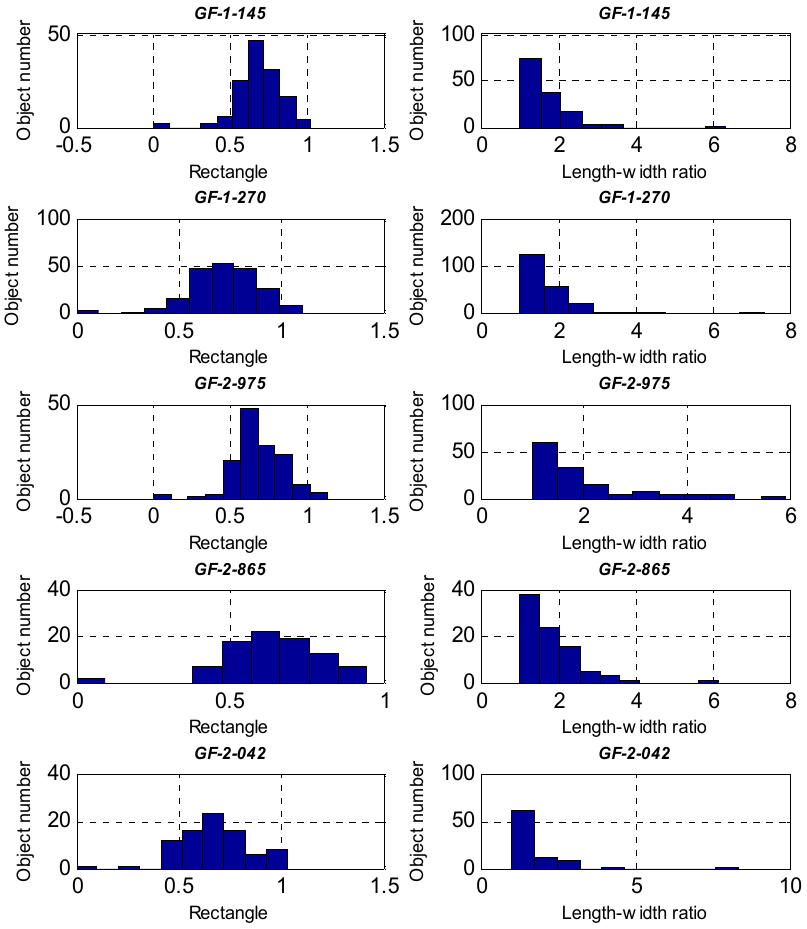
Figure 7. Rectangle and length–width ratio histogram of rough cloud detection for five GF-1/2 images.